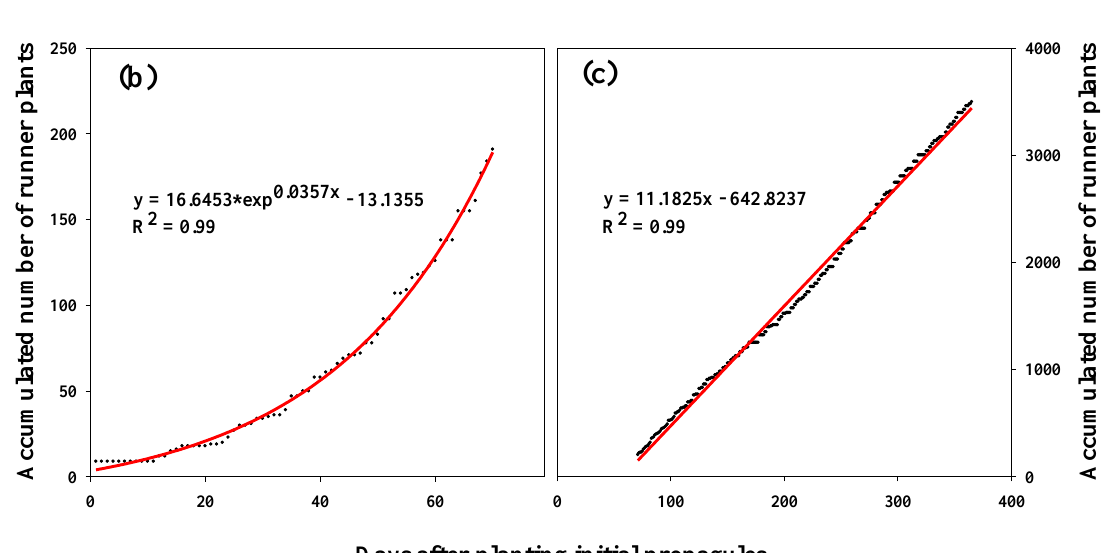
Figure 3. Time courses of cumulated numbers of total runner plants, runner plants released from a PFAL, and propagules producing runner plants in a plant factory using artificial lighting (PFAL) by autotrophic transplant production method ( a ). The runner plants were annually produced from nine initial propagules in 3.6 m 2 propagation area (five cultivation beds; maximum capacity number of propagules: 160). The accumulated number of total runner plants two different regression, exponential ( b ) and linear types ( c ) depends on days after planting initial propagules.